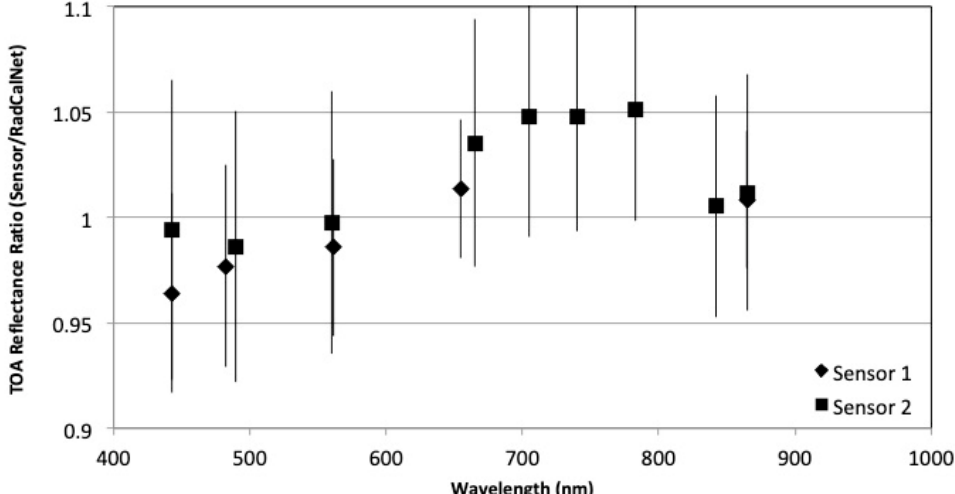
Figure 10. Comparison of Sensors #1 and #2 to the RadCalnet results of Site A. Uncertainty bars are based on the standard deviation of the temporal averages.